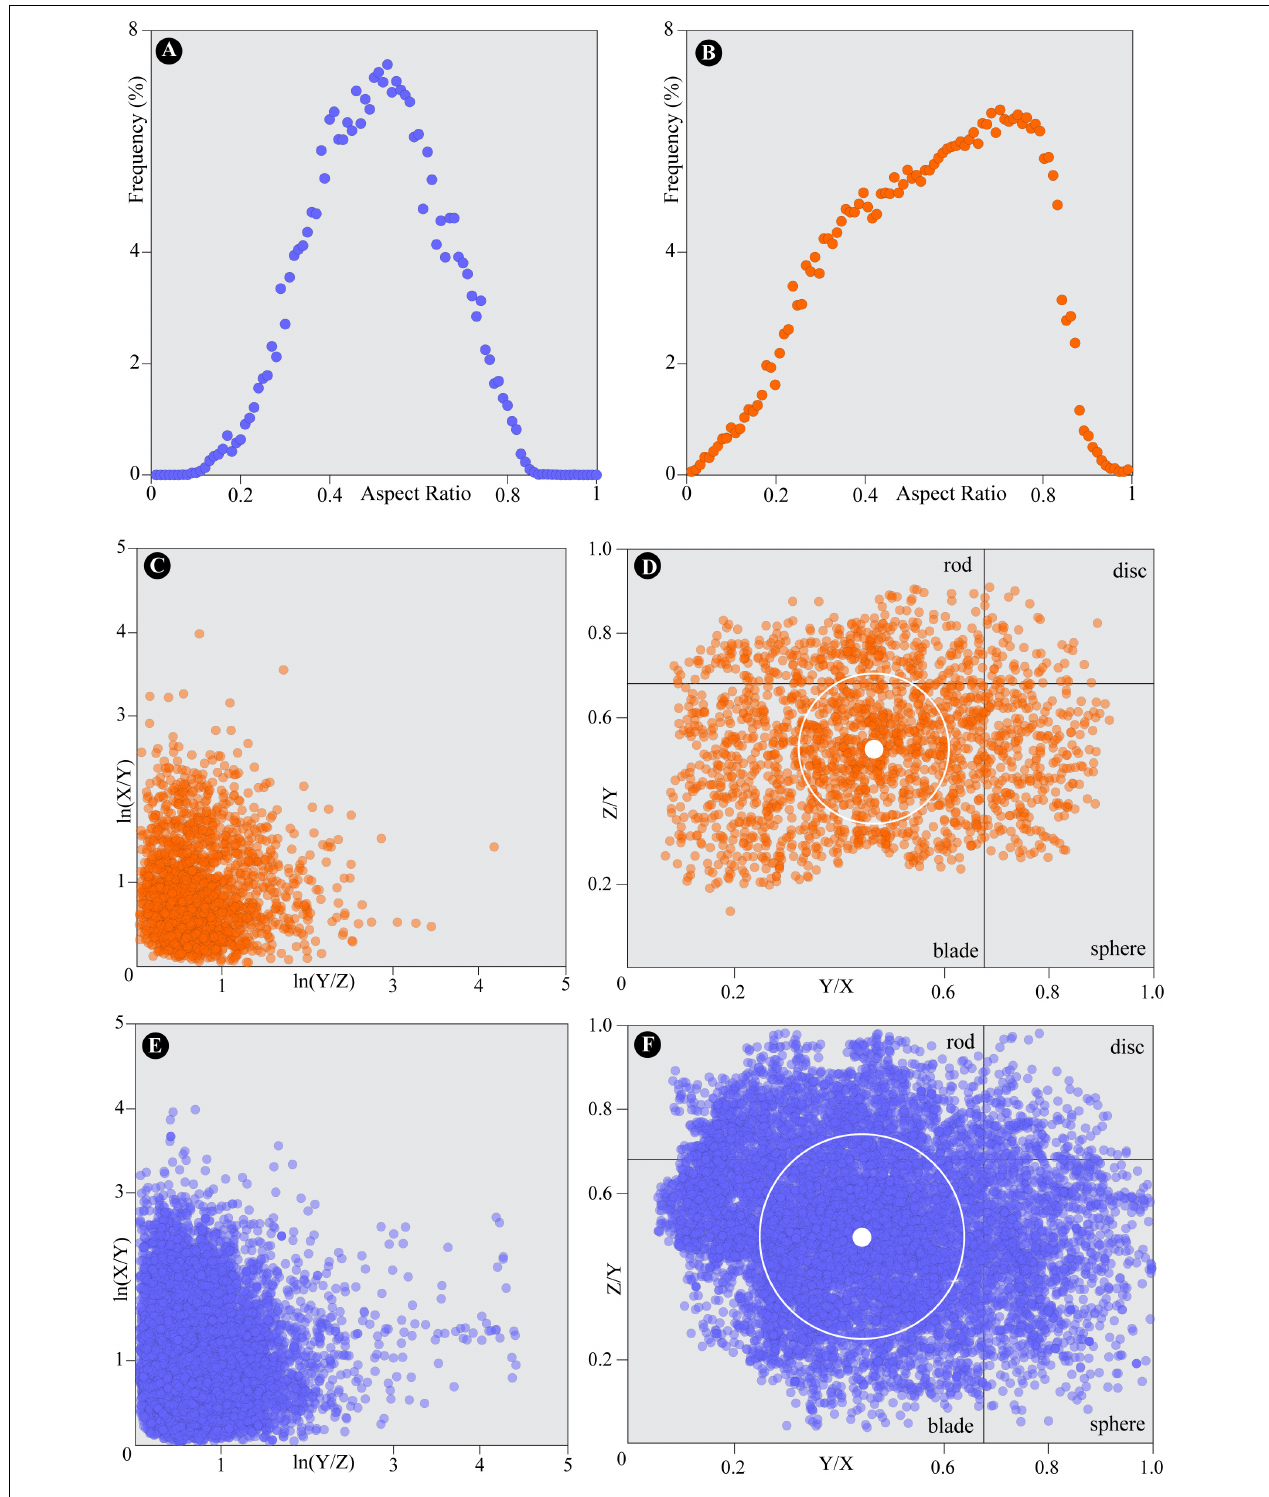
FIGURE 13 | 3D quantitative fabric analysis. (A) Frequency of Cpx aspect ratio. (B) Frequency of Qtz aspect ratio. (C) Flinn diagram of Qtz pseudo-grains. (D) Zingg diagram of Qtz pseudo-grains. The average and the standard deviation are reported. (E) Flinn diagram of Cpx pseudo-grains. (F) Zingg diagram of Cpx pseudo-grains. The average and the standard deviation are